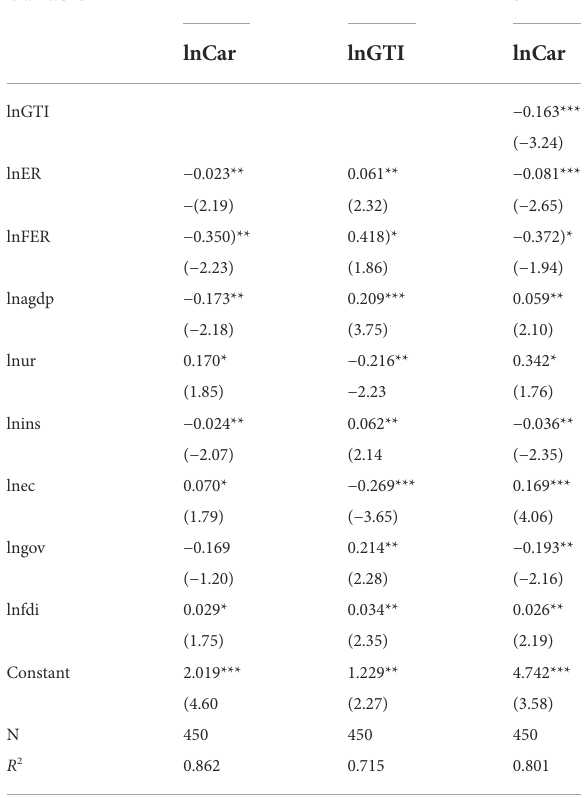
TABLE 2 Benchmark regression analysis